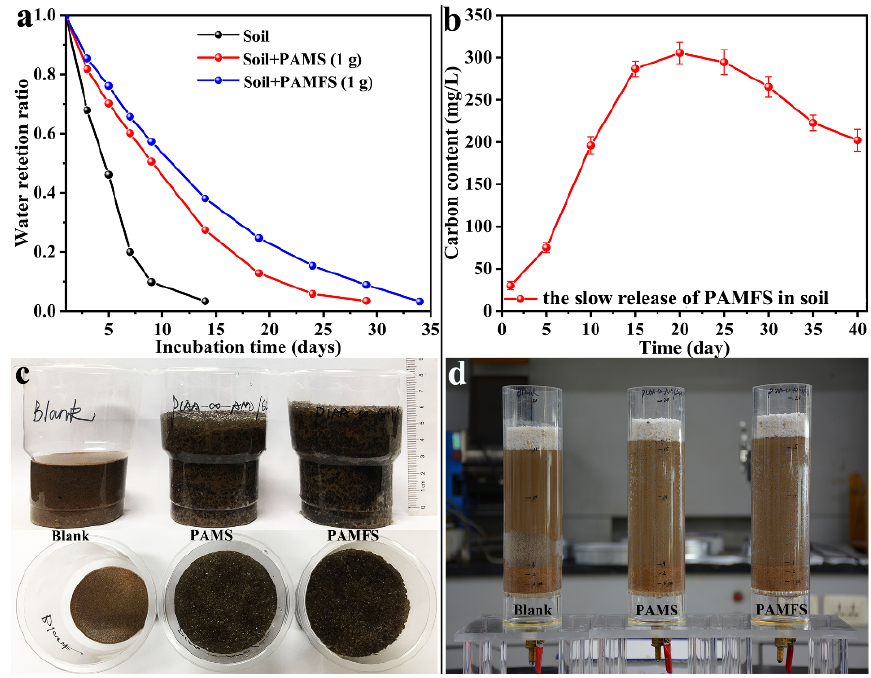
Figure 7. Water-holding ratio and water-retention capacity of soil with the PAMS and PAMFS ( a ); the slow release of PAMFS in soil ( b ); the digital photo of water-retention behaviors of soil samples: soil only, soil mixed with 1 g of PAMS and soil mixed with 1 g of PAMFS ( c ); digital photo of the soil column leaching experiment: soil only, soil mixed with 4.2 g (1 wt%) of PAMS and soil mixed with 4.2 g (1 wt%) of PAMFS ( d ).